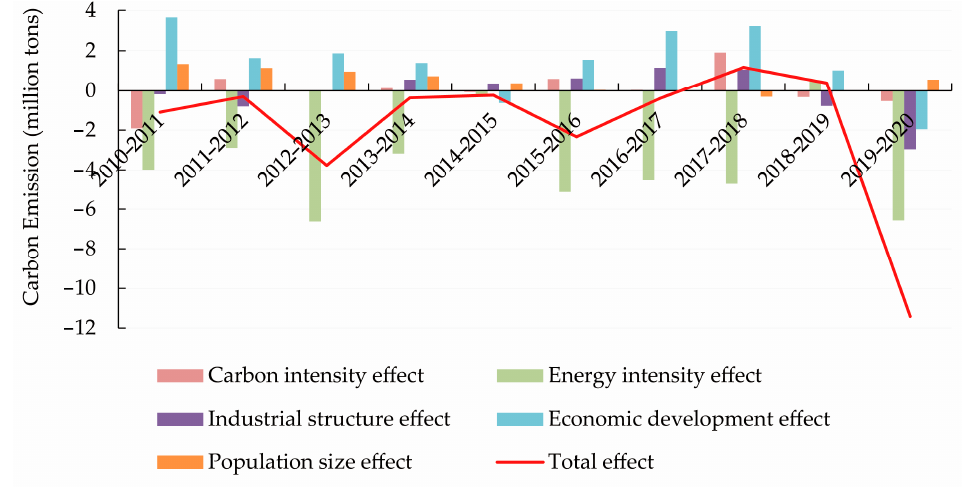
Figure 3. The annual contribution of five decomposition factors to carbon emissions.